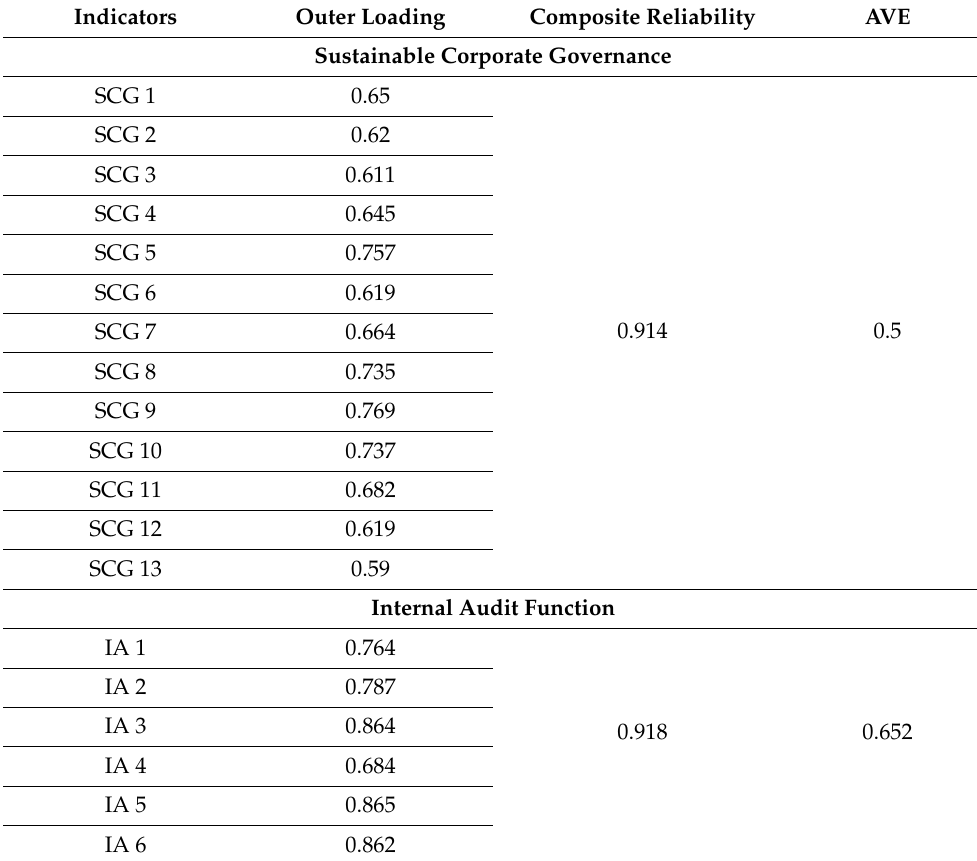
Table 5. Assessment of Measurement